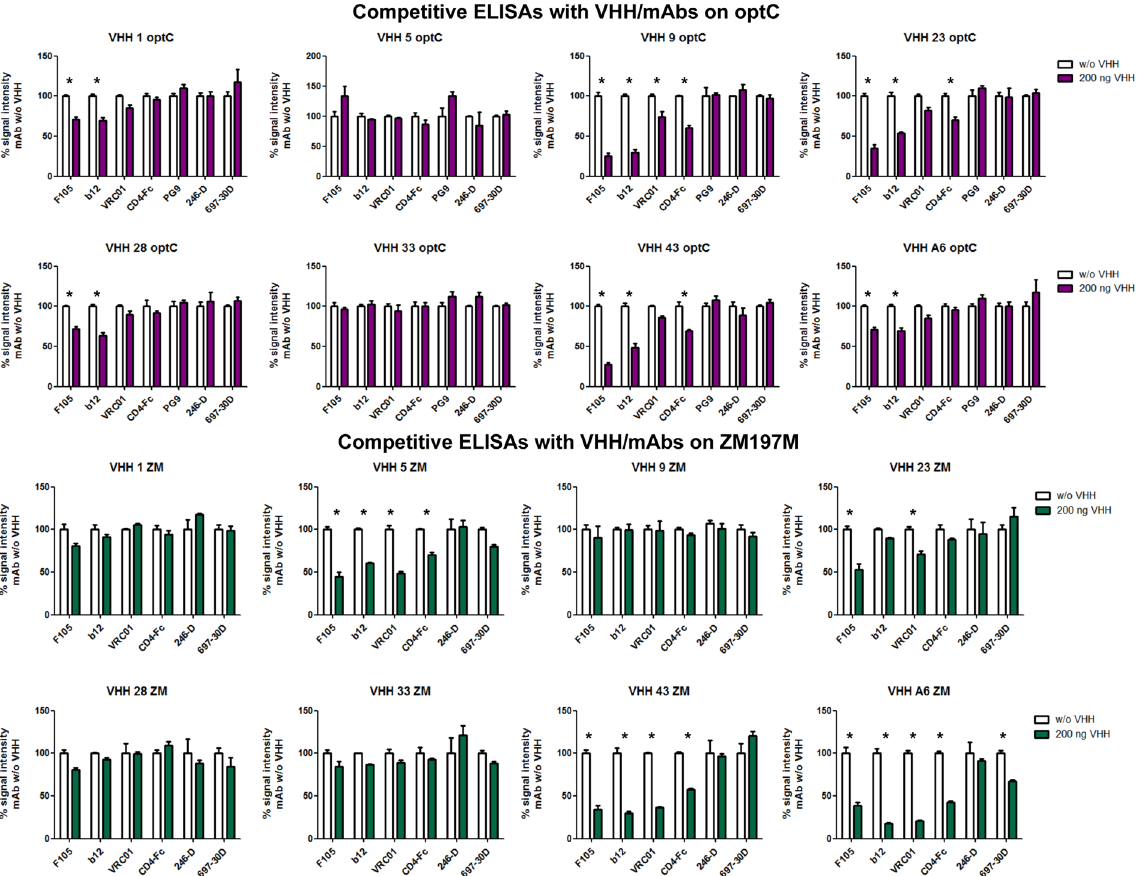
Figure 5. Competitive ELISA with VHH and known mAbs on optC and ZM197M SOSIPs. On optC (upper part), CD4bs ligands compete with VHH-9, VHH-23, VHH-43, A6, less with VHH-28 and VHH-1; on ZM197M (lower part), CD4bs ligands compete with A6, VHH-43, VHH-5, VHH-23, less/not with VHH-1, VHH-28, VHH-33. Detection of competition also depends on strength of VHH binding to the respective SOSIP (see Supplementary Figure S5: VHH-9 does not bind ZM197M −> no competition detectable). Stars indicate competition, see also legend to Supplementary Table